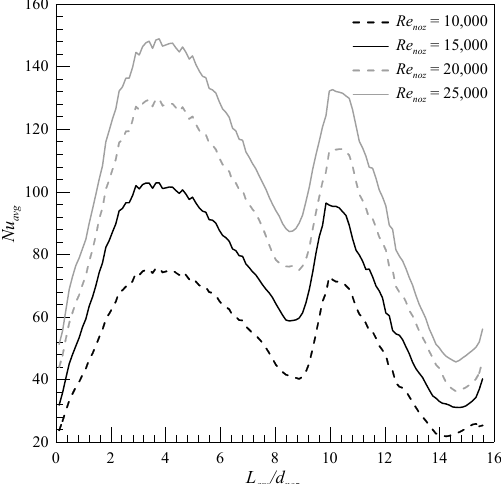
Figure 16. Spanwise average Nusselt number on the target surface of the compound cooling unit at different Re noz .